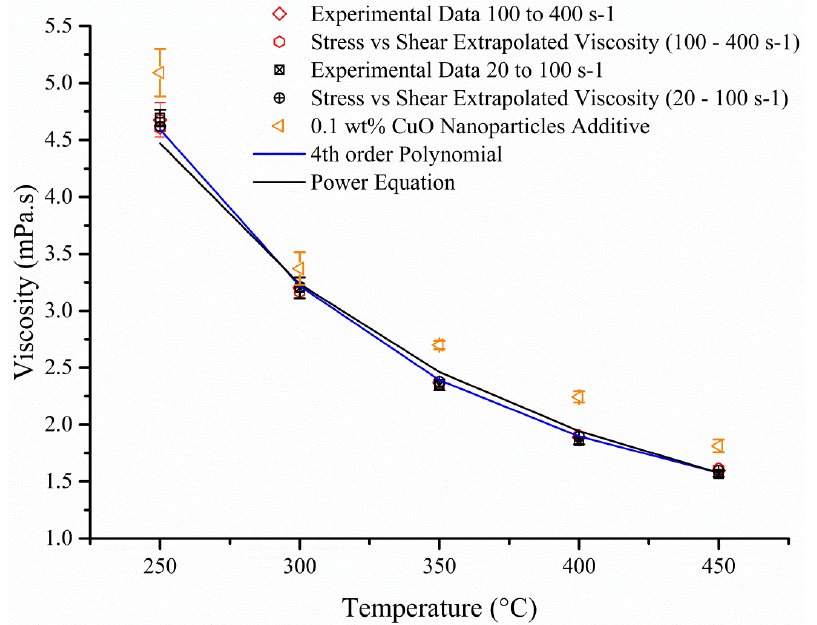
Figure 6. Viscosity of molten salt against temperature. Addition of 0.1 wt % CuO led to an increase of 10.8%, 4.7%, 12.9%, 18.3%, 14.9% for 250 °C, 300 °C, 350 °C, 400 °C, 450 °C respectively when compared to the 4th order